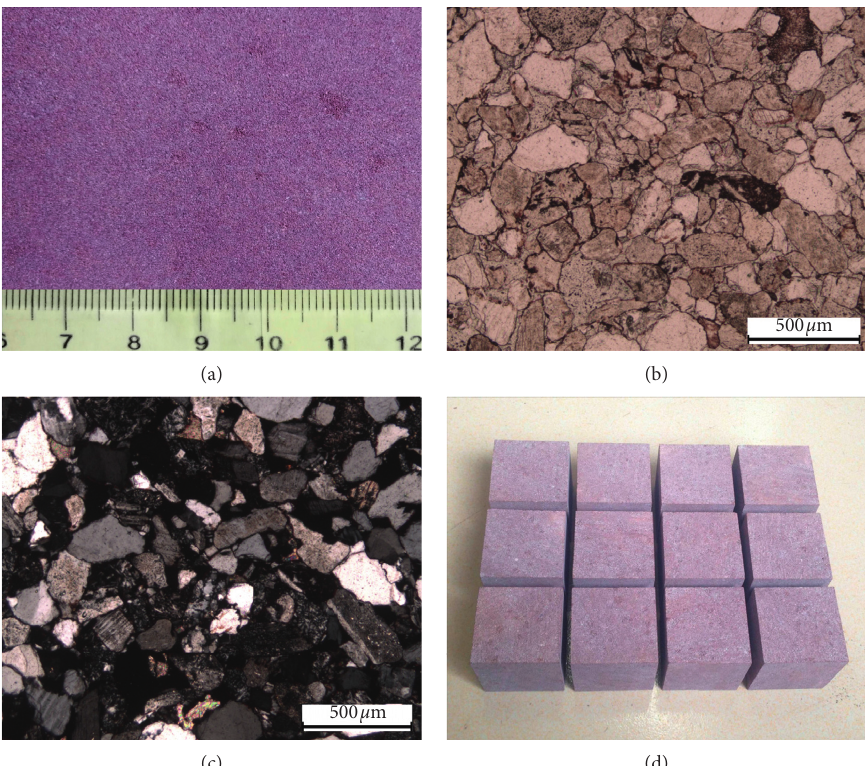
Figure 1: Red sandstone material and samples: (a) naked-eye observation, (b) plane-polarized light, (c) cross-polarized light [36], and (d) cube samples.